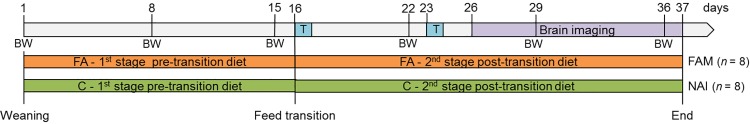
Experimental design.All animals were fed a first stage pre-transition diet from weaning to d 15, with (FA) or without (C) additive. On d 16, a feed transition was performed and the pre-transition diet was replaced by a post-transition diet of different composition, with or without the same additive. During the 2-choice tests (T) performed on d 16 and d 23, the naive (NAI) and familiarized (FAM) piglets had the choice between the post-transition diet without additive and the same diet with the additive. Body weight was assessed weekly (BW) and, from d 26 onwards; animals were subjected to 2 brain imaging sessions to assess the brain metabolism triggered by the exposure to the flavor of the C or FA post-transition diet.